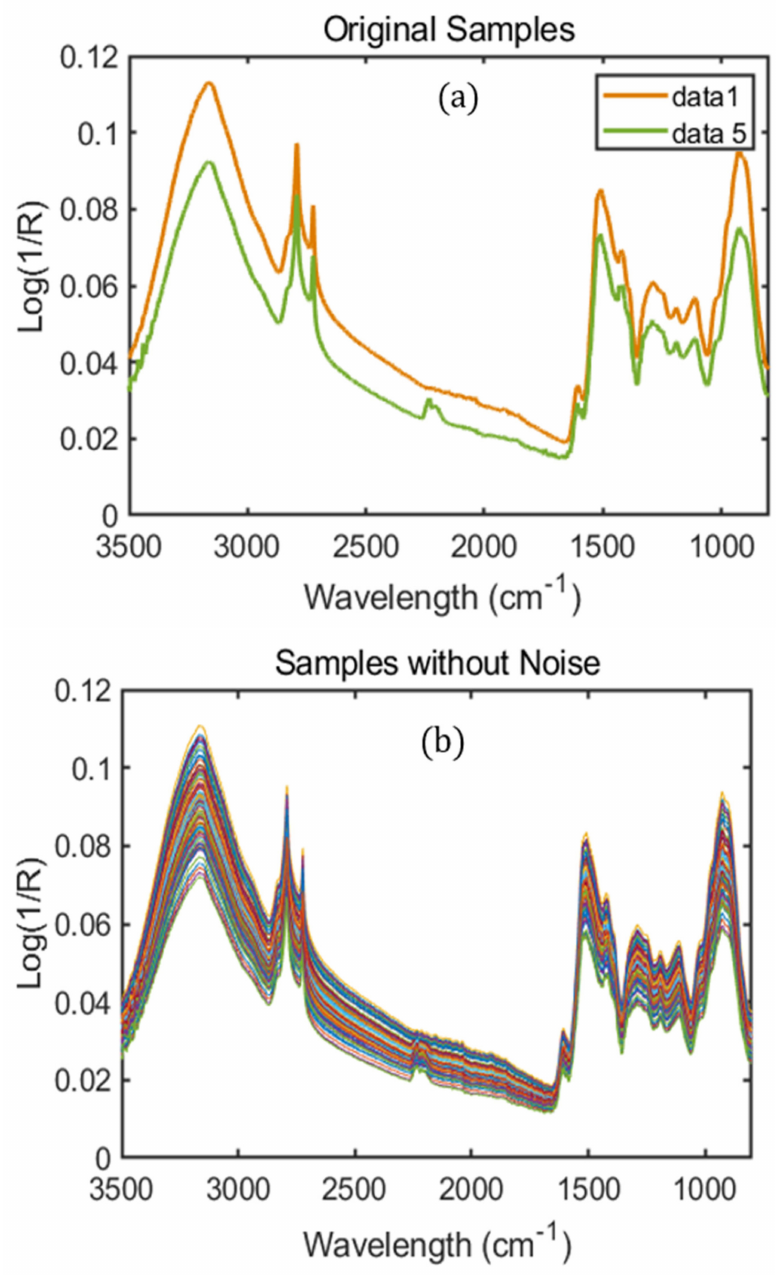
Figure 4. FT-IR spectra developed between two replicates (1.95_1 and 1.95_5) for one variety of concentrations, i.e., 1.95 ( a ). A total of 100 mixed samples spectra of moringa powder for one concentration generated by the Dirichlet distribution ( b